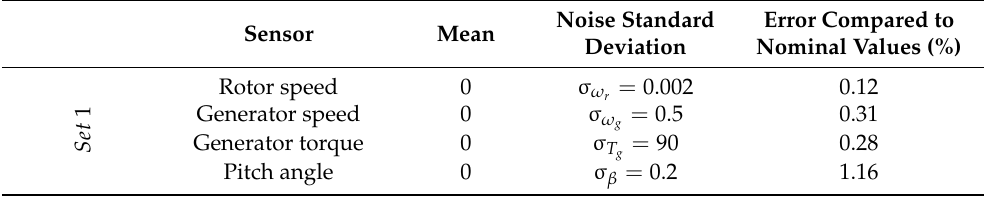
Table 4. Parameters of the different measurement error